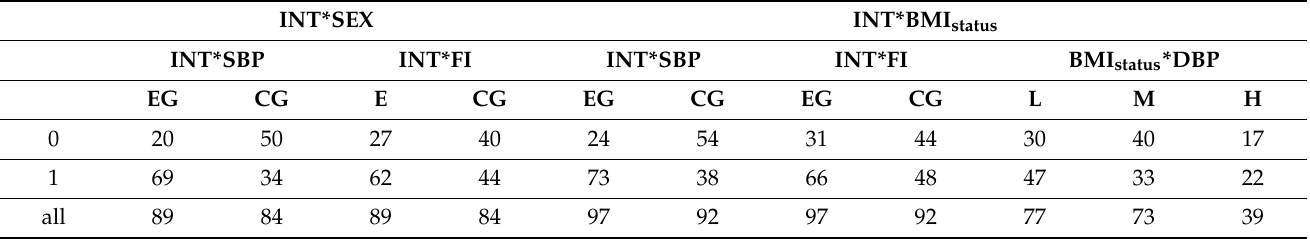
Figure 2. Co-occurrence of the changes in independent variables in the control group concerning sex and BMI status . Taxonomical dendrogram illustrates similarities and distances (strength) of linkages. Table 5. Table of marginal quantity concerning observed quantity in INT*SEX and INT-BMIstatus models for dependence: INT effect in SBP and INT effect in FI in the first model and INT effect in SBP, INT effect in FI, and BMIstatus effect in DBP in the second